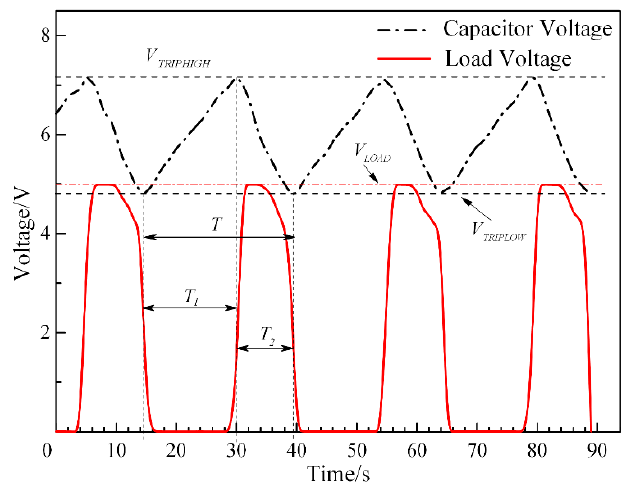
Figure 8. Dependency of the load and C 2 voltage on time domain.